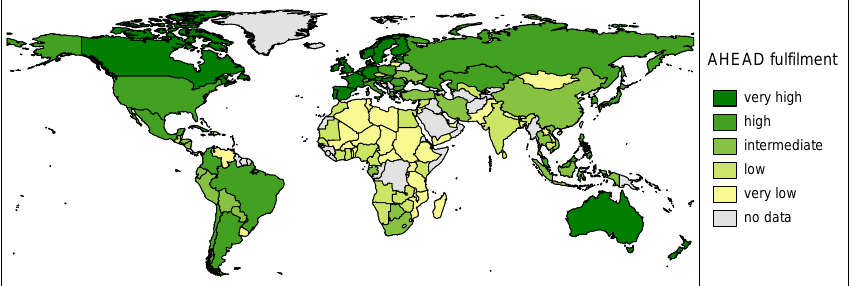
Figure 3. AHEAD fulfilment at global scale for present conditions (water data: ensemble mean across all participating ISI-MIP climate and water models for the baseline 2000). Result values for current and future calculations for all GCMs and RCPs are published on figshare (Lissner et al.,